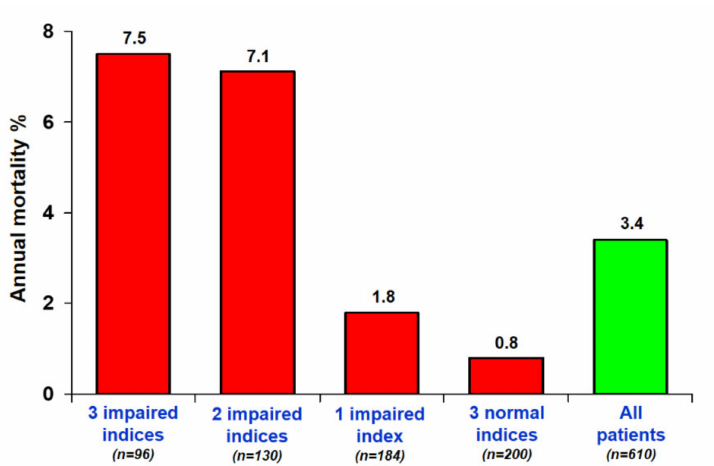
Figure 4. Annual mortality rates and numbers of positivity criteria. The annual mortality rate is highest in patients with the highest SE score.